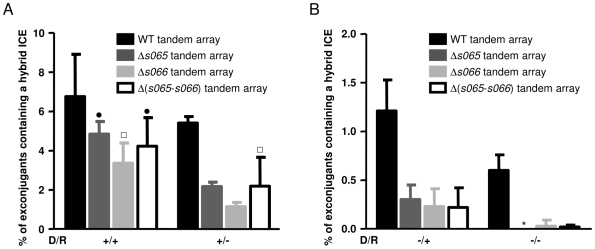
Involvement of recA, s065, and s066 in the formation of hybrid ICEs.
recA+ (A) or recA (panel B) donor strains, which contained either wild-type (WT), Δs065, Δs066, or Δ(s065-s065) SXT-R391 tandem arrays, were used as donors in these assays. The recipient strains were either E. coli VB38 (recA+) or E. coli VB47 (recA−). D/R + and – indicate the recA genotype of the donor and recipient strains, respectively. SetDC was expressed from a plasmid when recA donors were used. Bars represent the percentage of exconjugants containing hybrid ICEs and were calculated by dividing the number of exconjugants containing hybrid ICEs (red TcR SuR TmR CFU) by the total number of exconjugants (TcR SuR TmR CFU). The means and standard deviations obtained from at least three independent assays are shown and the number of colonies containing a hybrid ICE counted for each assay is presented in Table S2. Note the differences in the scale of the y-axis in panels A and B. One-way ANOVA with a Tukey-Kramer post-test was used to compare the means of hybrid ICE-containing exconjugant colonies. The confidence interval for the comparisons of mutant tandem arrays relatively to WT tandem arrays was P<0.001, except □ which indicates P<0.05 and • which indicates that the difference was statistically not significant. * indicates that the percentage of exconjugants bearing a hybrid ICE was below the limit of detection (<0.01%).